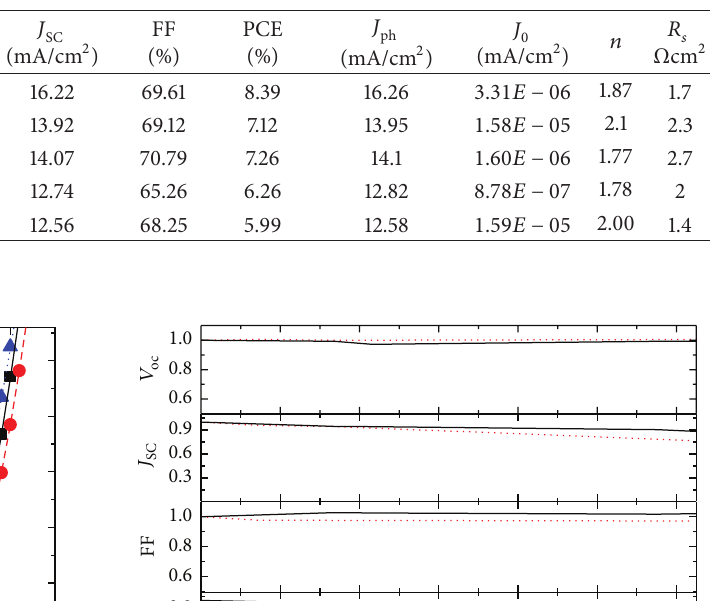
Table 1: Photovoltaic performance parameters for conventional and inverted PSCs with ZnO as ETL under the simulated AM 1.5G illumination of 100mW/cm 2 fresh or stored after 625 hours.